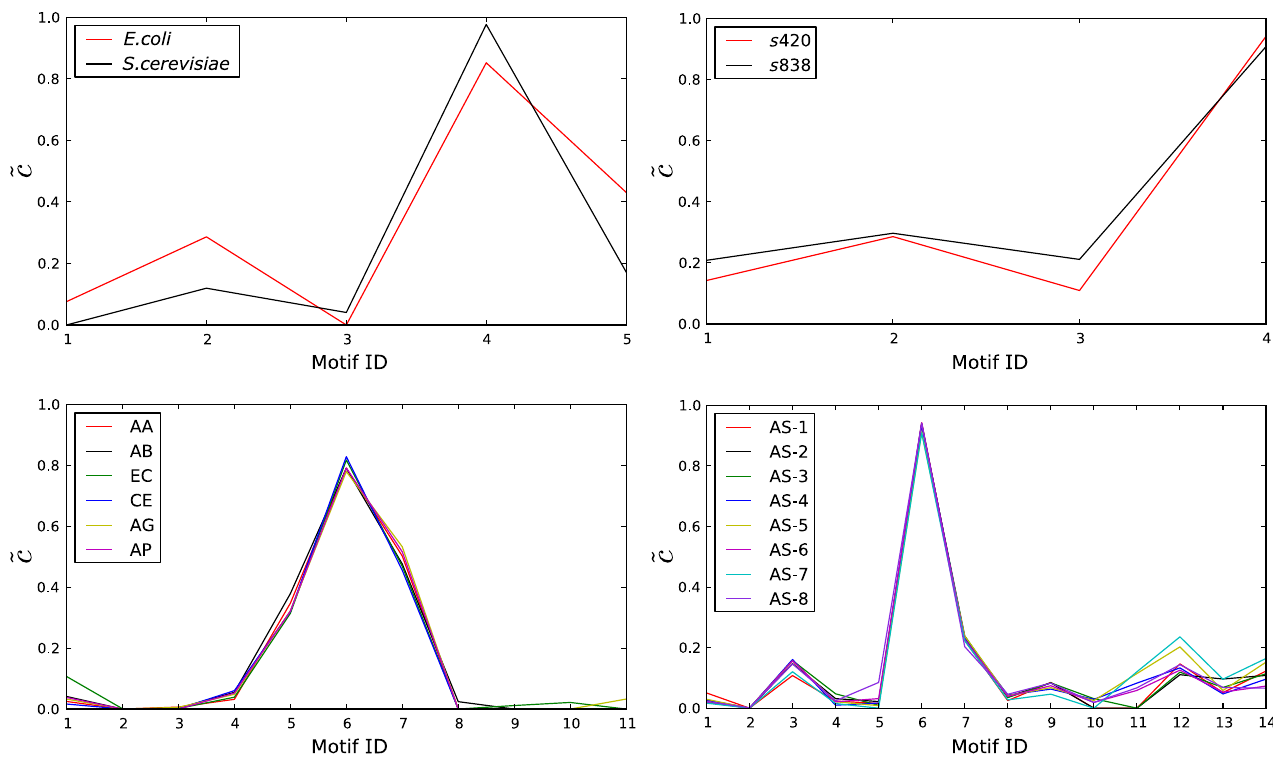
FIG. 1. The motif-significance profiles of various networks corresponding to the covers given in Tables II, IV, V, and VI.